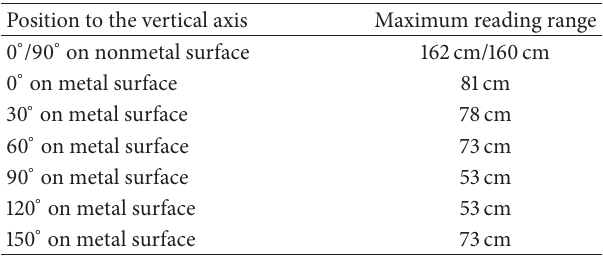
Table 1: Maximum reading distance of a tag glued on a metallic tank depending on its